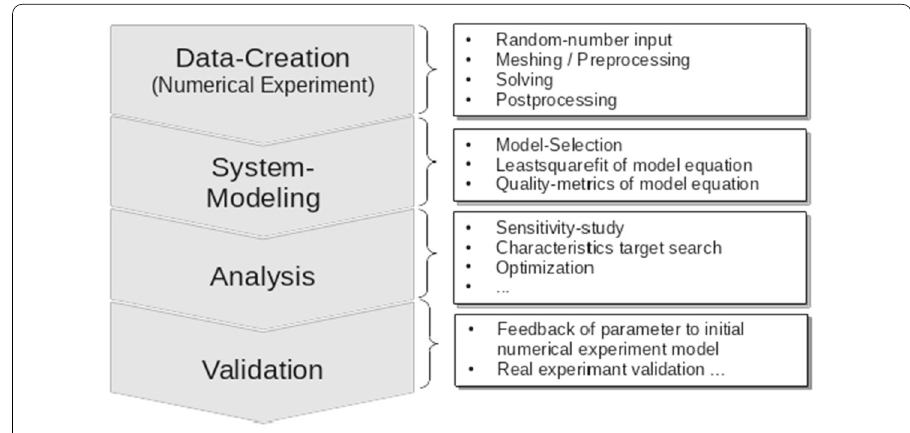
Fig. 3 Calculation procedure. Schematic sketch of calculation procedure, similar to